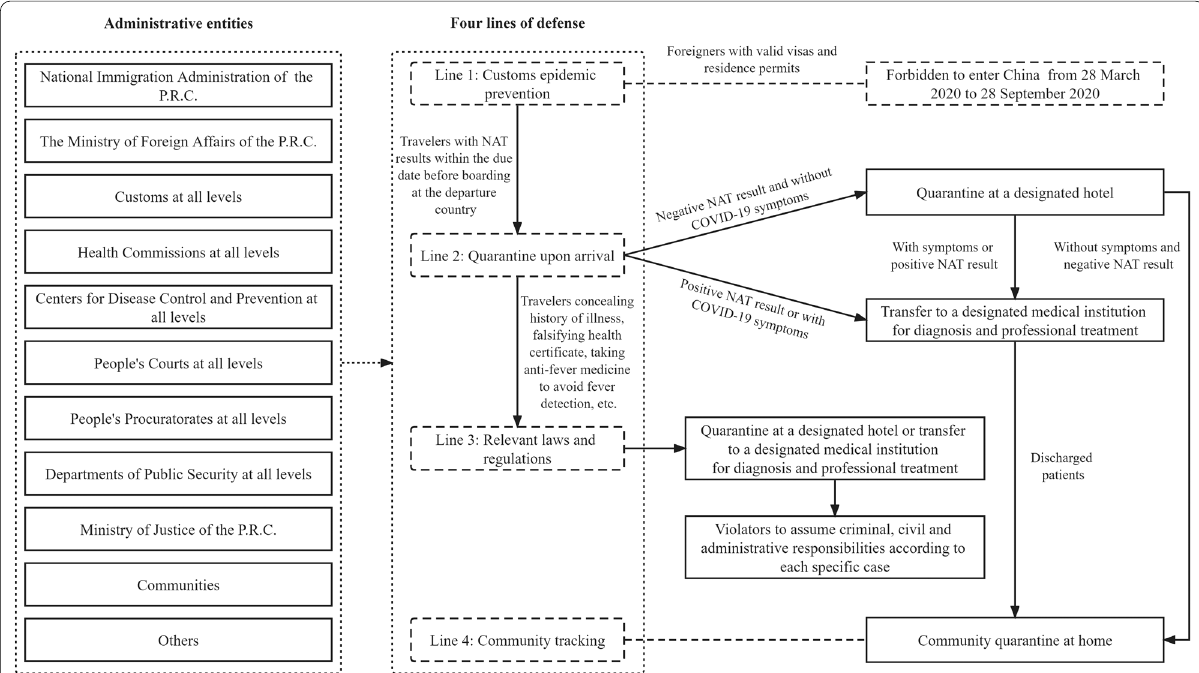
Fig. 1 China’s governance model against imported infections from international